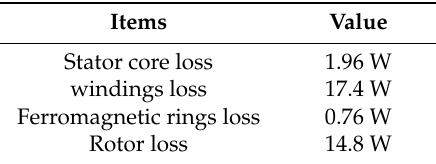
Table 3. Main Loss in the Prototype.